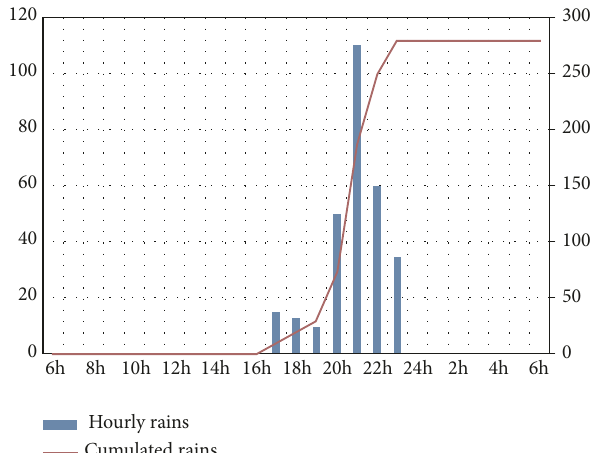
Figure 4: Hyetogram of the rain at the pixel that provided the maximum rain, at Batouri, from 18 November at 6:00 am GMT to 19 November at 6:00 am